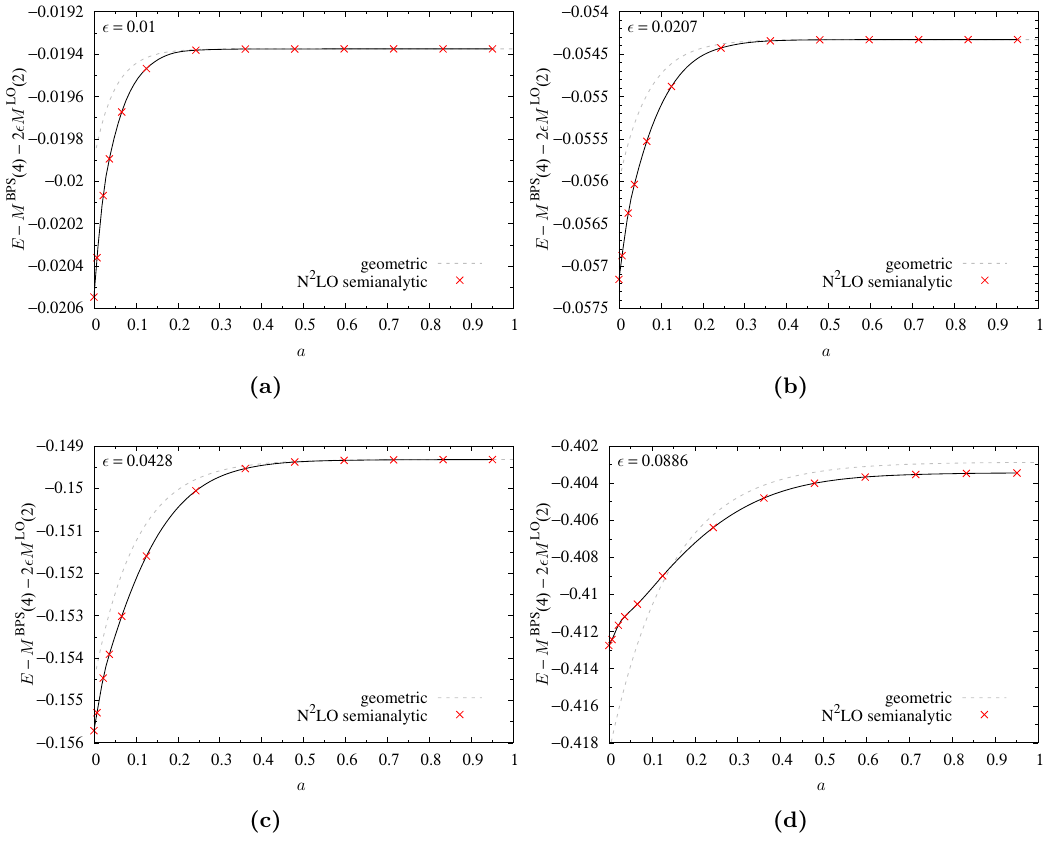
Figure 15 . The N 2 LO corrections to the energy for two N = 2 baby Skyrmions as a function of the separation distance 2 a , see figure 12. The panels correspond to different values of (cid:15) : (a) (cid:15) = 0 . 01 , (b) (cid:15) = 0 . 0207 , (c) (cid:15) = 0 . 0428 and (d) (cid:15) = 0 . 0886 . The gray-dashed line is calculated as the geometric cut at x = 0 of the spherically symmetric compacton energy. The red crosses show the results of the N 2 LO contribution to the energy from the PDE calculation of δf and δθ . The black line is a cubic interpolation between the PDE results. For (cid:15) = 0 . 0886 (d) the N 2 LO perturbation energy crosses over the geometric estimate and hence the excess energy starts to build up at this “large” value of (cid:15) for N = 2